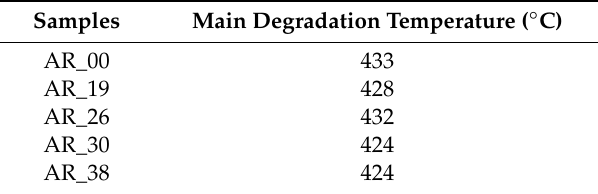
Table 2. Thermogravimetric analysis (TGA) measurements.